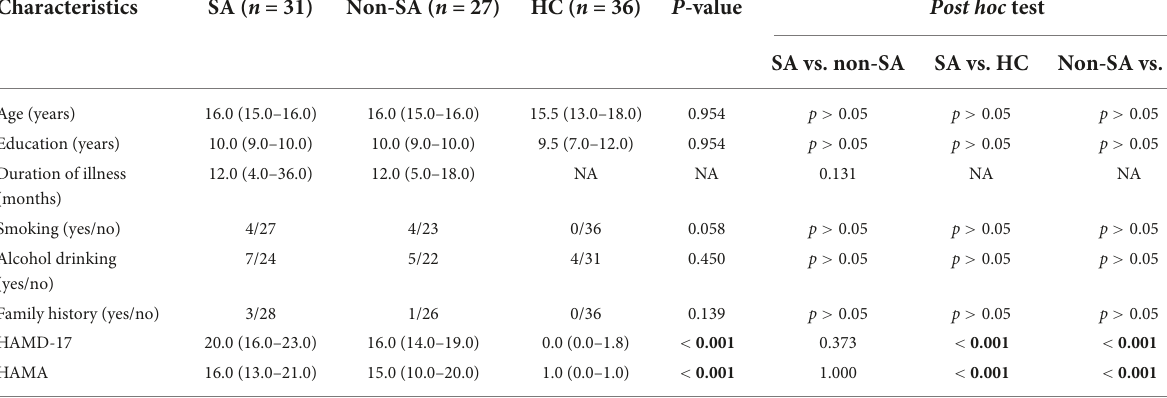
TABLE 1 Demographics and clinical characteristics of the participants included in the present study.